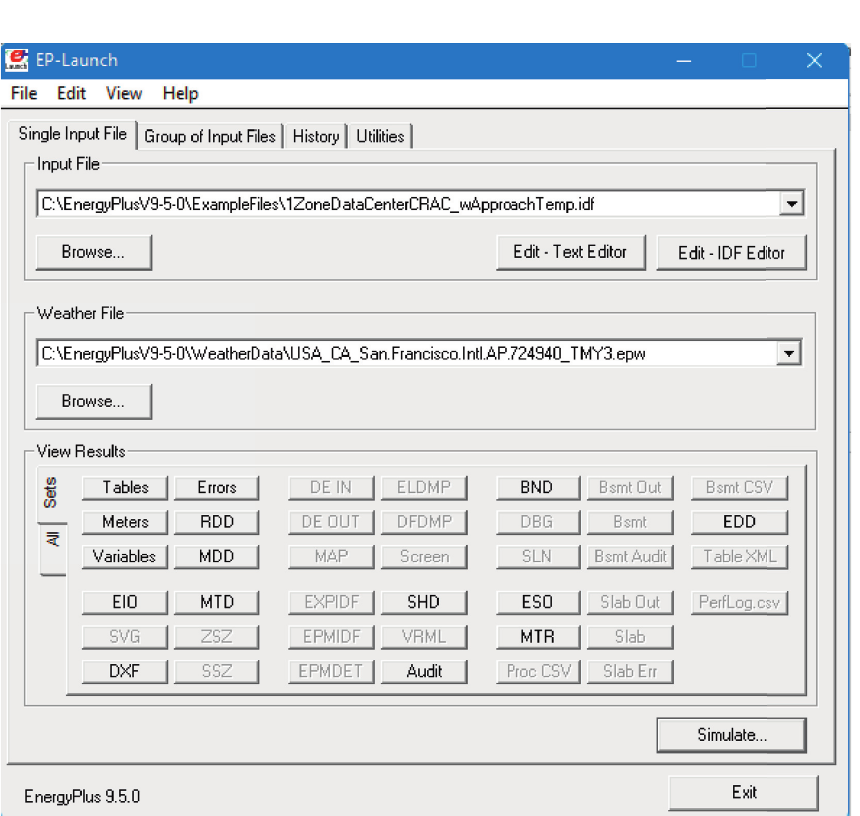
Figure 3: User interface of the Energy Plus